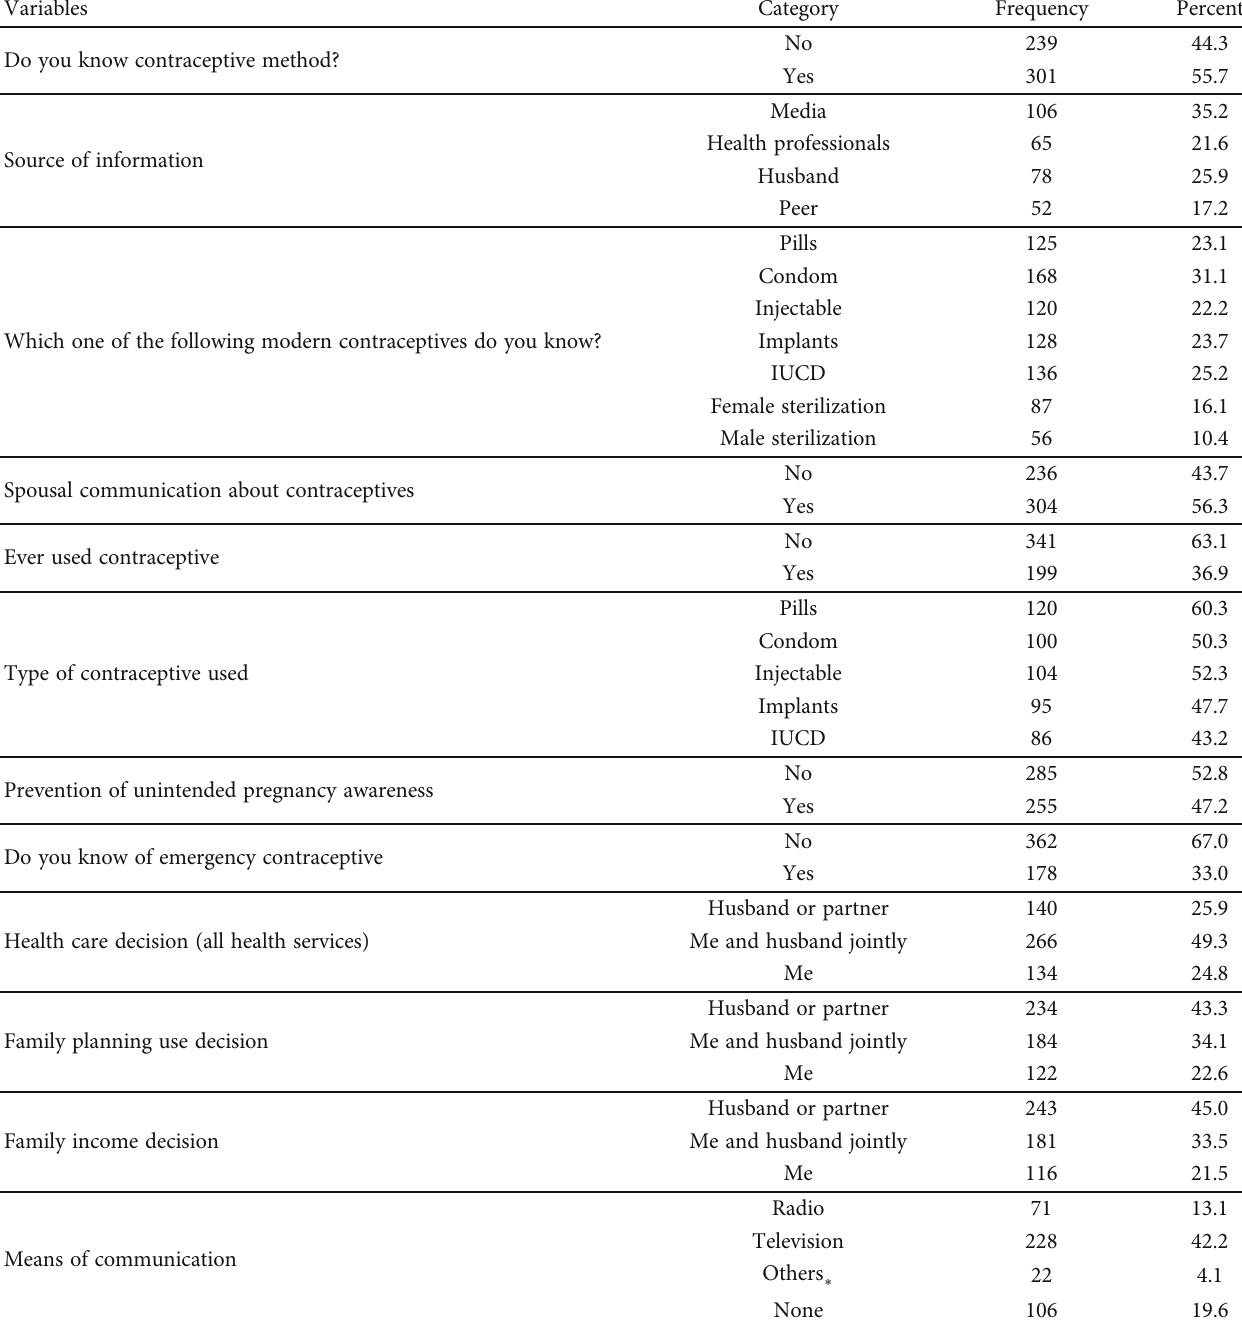
Table 3: Awareness towards contraceptive method of pregnant women living in Ilu Gelan district, West Shewa Zone, Ethiopia, 2021 ( n = 540